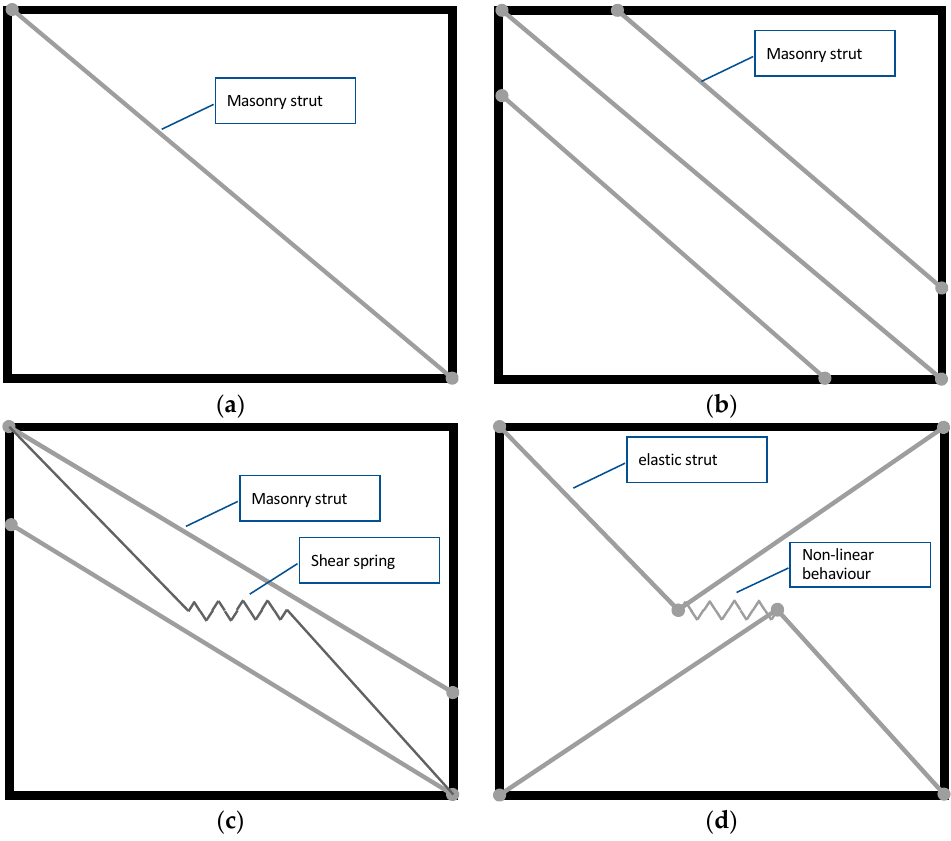
Figure 1. Macro Models for masonry infill walls: ( a ) single strut model, ( b ) Three Diagonal model (based on [31]) ( c ) Proposed multi-strut model [32], ( d ) Macro-model proposed by Rodrigues et al., 2010) [33].